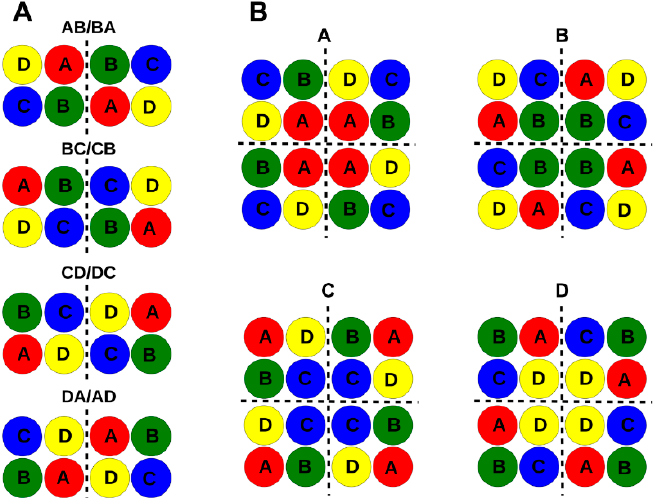
Figure 3. Possible arrangements of Trk1 monomers into symmetrical dimers and tetramers (top view). Each coloured circle represents the complete MPM motif indicated. ( A ) Dimers with interfaces between monomers formed by (from top to bottom) MPMs AB/BA, BC/CB, CD/DC, and DA/AD. ( B ) Tetramers in which a possible central pore could be formed by either MPM A, B, C, or D (colours as in Figure 1). The interfaces between monomers are indicated by dashed lines.